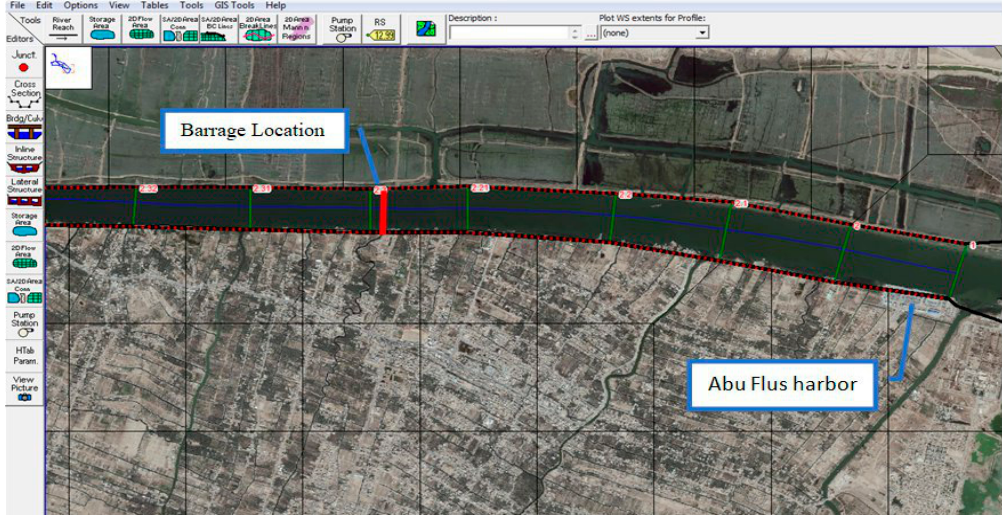
Figure 11. Suggested regulator location.